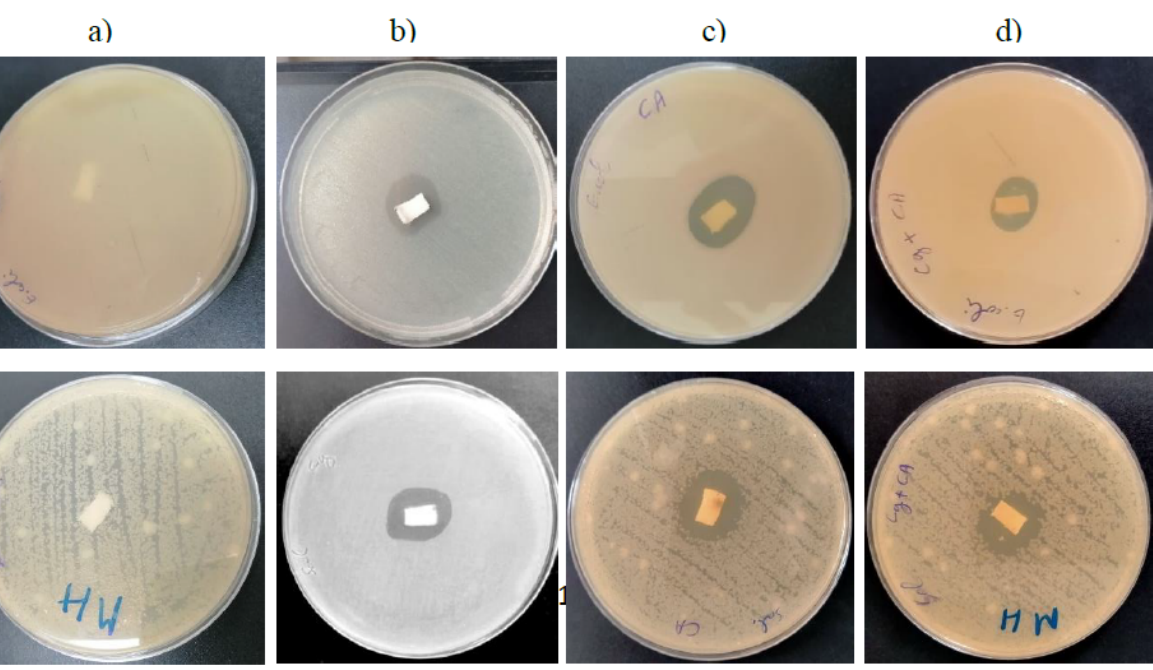
Figure 6. Antibacterial activity results of the ( a ) untreated cotton, ( b ) cotton grafted with clove oil microcapsules, ( c ) cotton grafted with cinnamon oil microcapsules and ( d ) cotton grafted with oil mixture microcapsules.